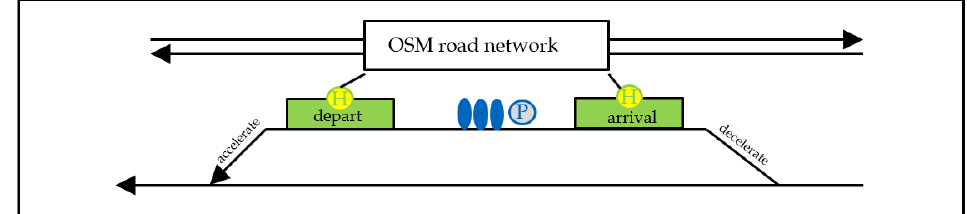
Figure 3. Schematic layout of a PRT station using SUMO’s